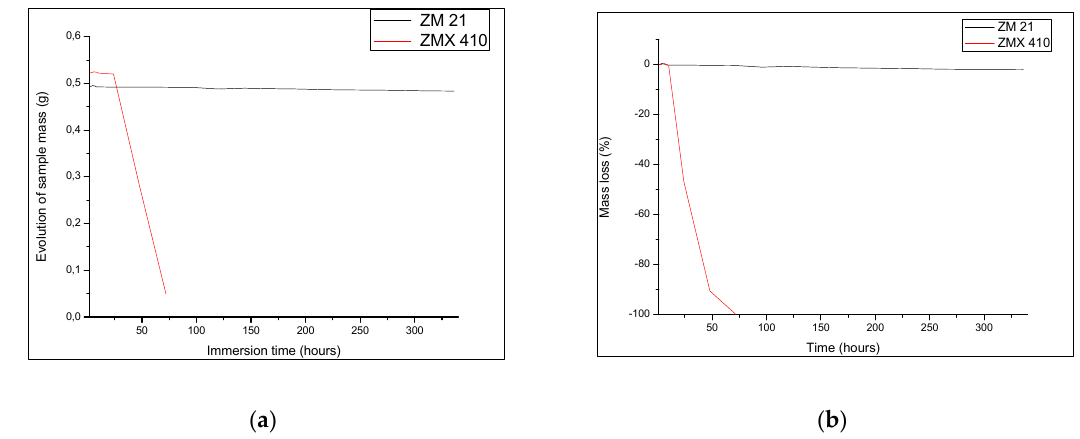
Figure 11. Quantitative behaviour of samples during immersion experiments: ( a ) variation of sample mass and ( b ) evolution of mass loss.